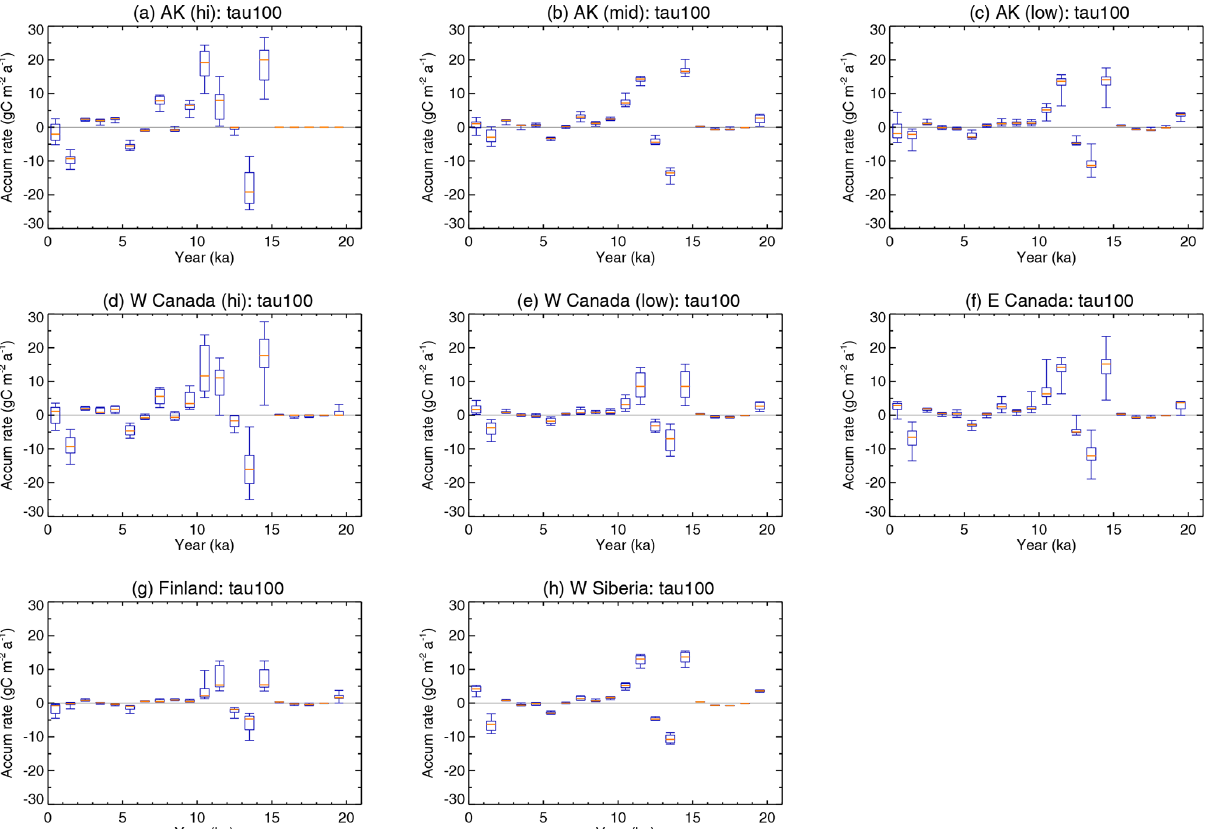
Figure 8. Millennial changes in the carbon accumulation rate (gCm − 2 a − 1 ) after the LGM for different circum-Arctic regions: (a) high Alaska, (b) mid-Alaska, (c) low Alaska, (d) high western Canada, (e) low western Canada, (f) eastern Canada, (g) Finland, and (h) West Siberia. The statistical distribution of the accumulation rates, aggregated for each region for each millennial period, is illustrated by a box– whisker plot. The lowest and highest whiskers of the box–whisker plots show the 10th and 90th percentiles, respectively. The lower and upper edges of the box show the 25th and 75th percentiles, respectively. The 50th percentile (median) is shown by the coloured bar in the box. Areas of each region are shown in Fig.